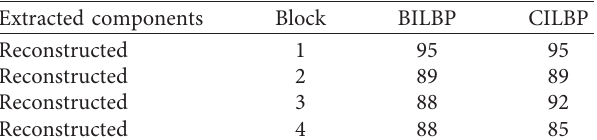
Figure 9: Comparative ROC Table 4: Identification results (%) with partition (1 × 4) and block CILBP.